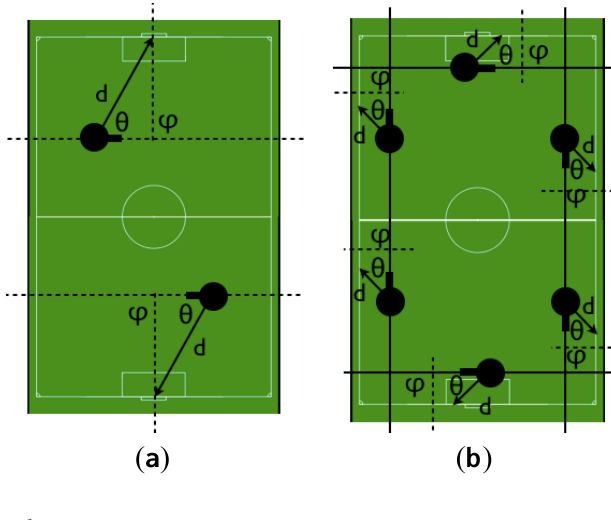
Figure 15. Possible robot positions (d, θ , φ ) deduced by a given landmark detection: ( a ) goal information; ( b ) borderline